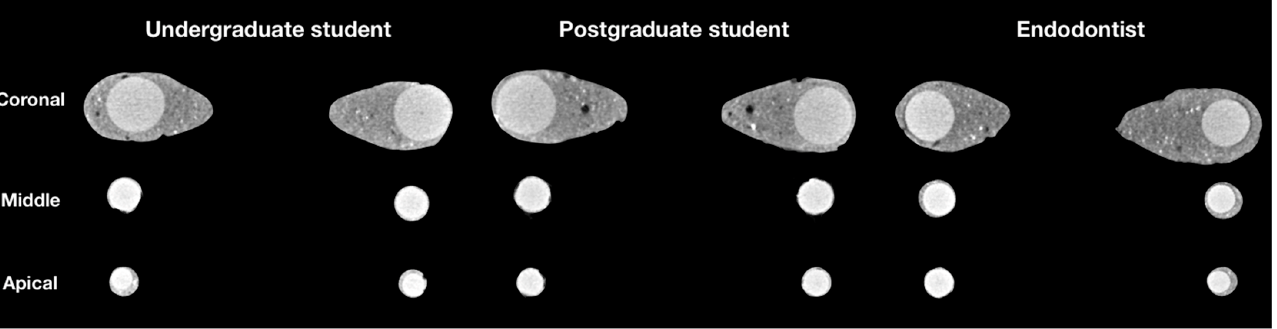
Figure 2. 2D cross-sectional images at the different thirds of the obturated root canals of random samples of US, PS and ED groups, demonstrating various porosity inside the fillings.